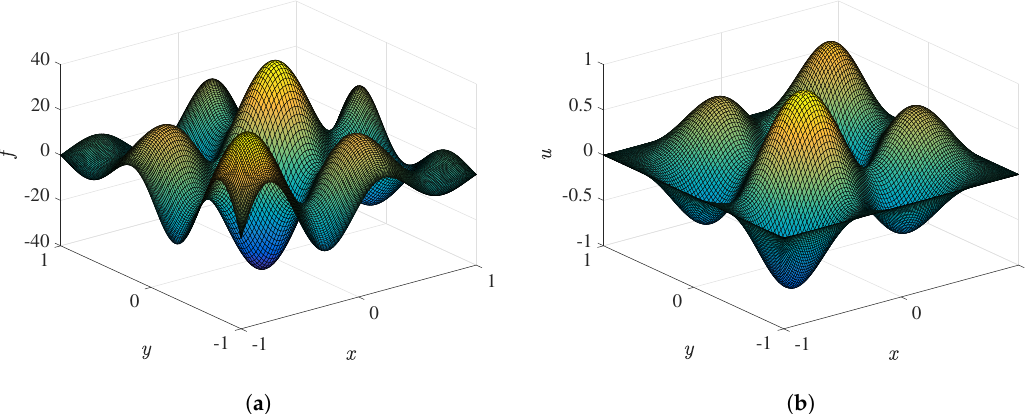
Figure 4. Values of the forcing term f ( x , y ) and the numerical solution u ( x , y ) of a 2-D Poisson equation with no exact solution are presented in ( a ) and ( b ), respectively. The numerical solution presented in ( b ) is at N = 128.